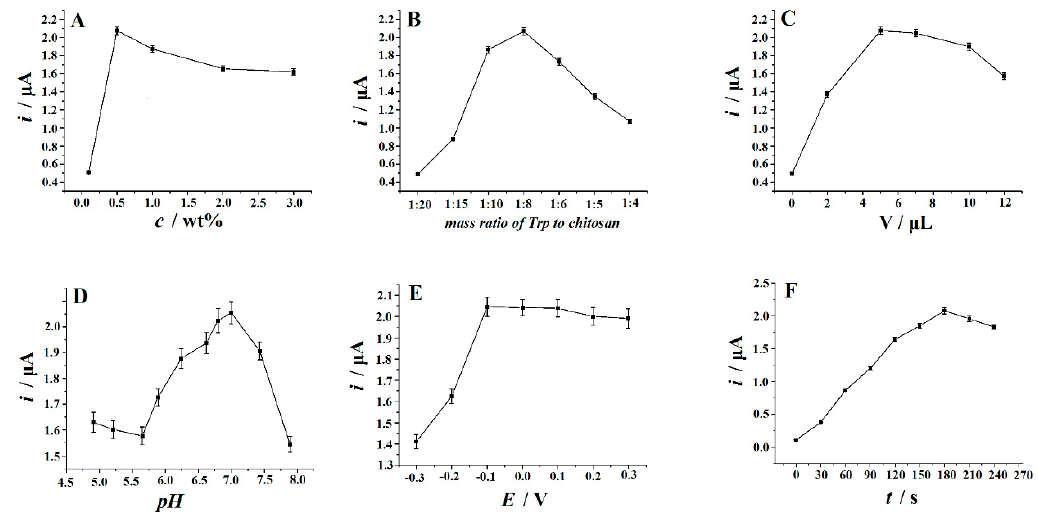
Figure 7. The effects of the concentration of chitosan ( A ), the mass ratio of Trp to chitosan ( B ), the dropping amount of Trp-chitosan suspension ( C ), the solution pH ( D ), the accumulation potential ( E ) and the accumulation time ( F ) on the oxidation peak current of 0.1 mM Trp at MIP/ABPE. When one parameter was changed, the other parameters were at their optimal values.